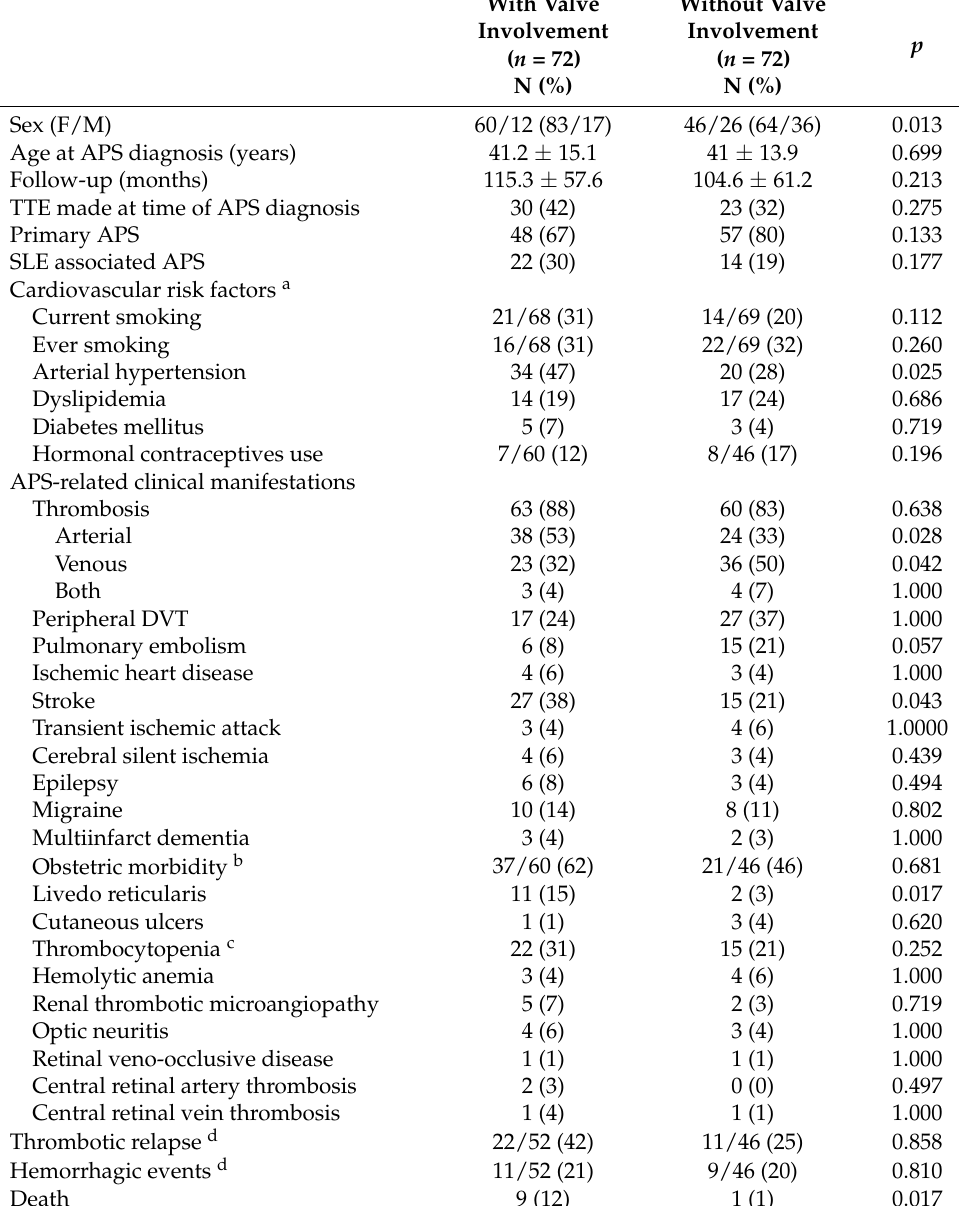
Table 1. Demographic characteristics, cardiovascular risk factors and APS related clinical mani- festations of patients with APS according to the presence of heart valve involvement detected by